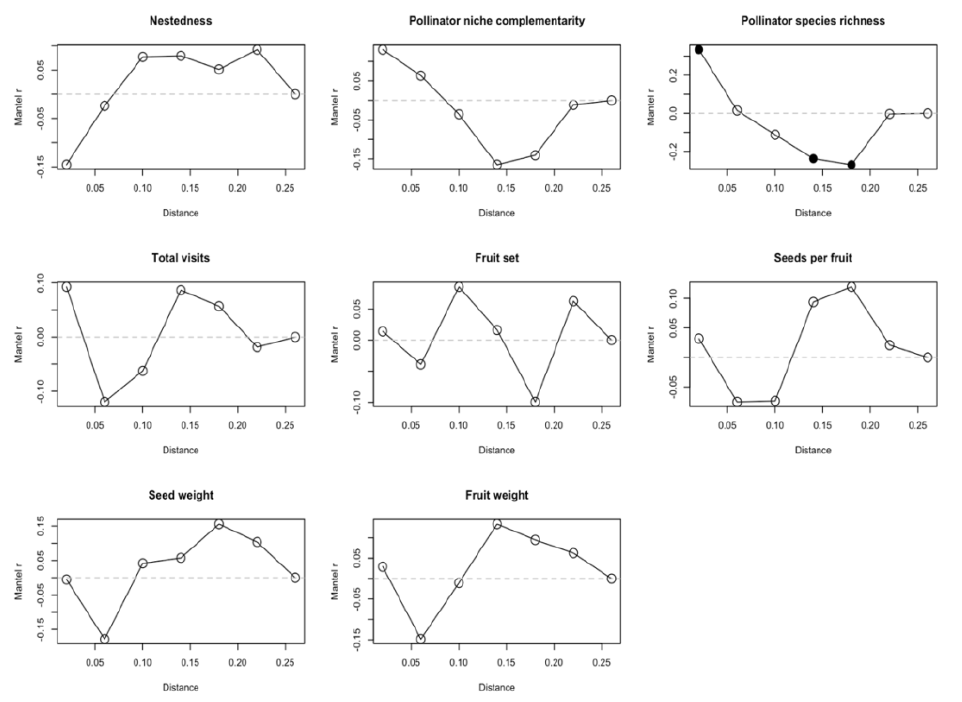
Figure S2 . Mantel correlograms showing a low spatial autocorrelation for the different variables included in the